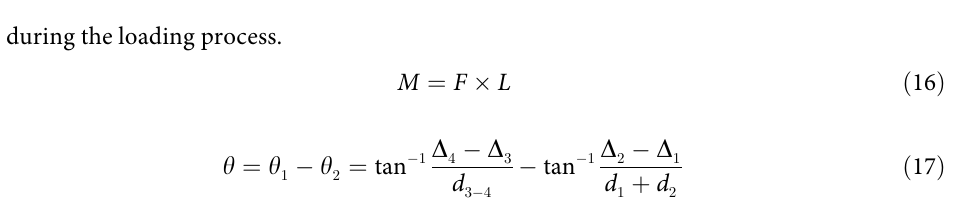
PLOS ONE | https://doi.org/10.1371/journal.pone.0276340 October 20,